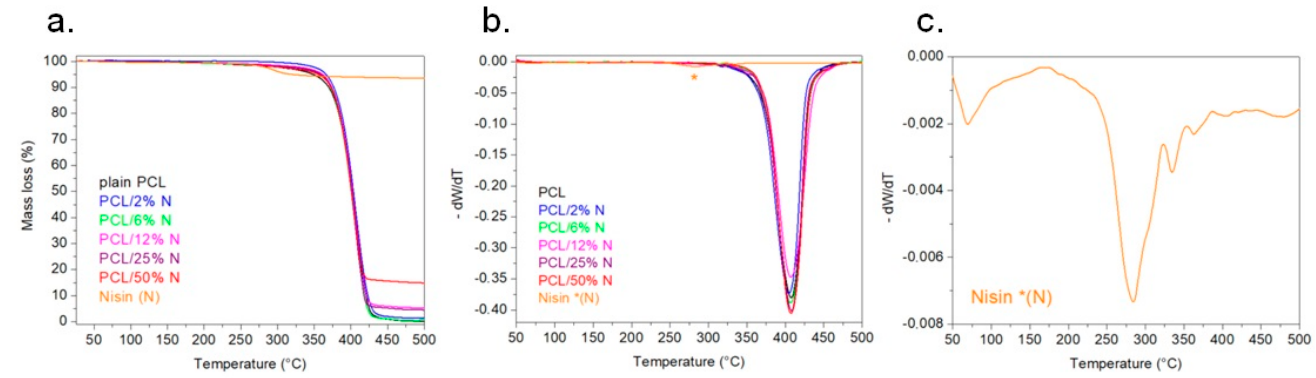
Figure 7. Nonisothermal TGA records of plain PCL and PCL with the addition of nisin under a nitrogen atmosphere ( a ), graphs of 1st derivation of TGA ( b ), and detail of 1st derivation of nisin TGA ( c ).